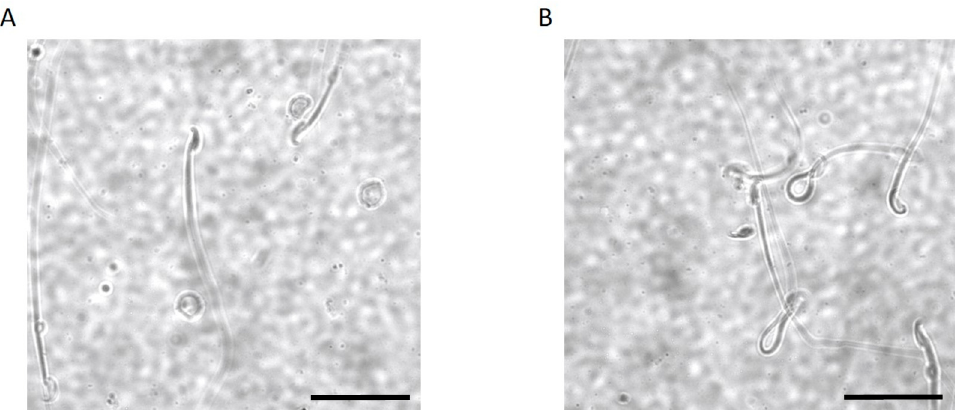
Figure 3. Viability and progressive motility of spermatozoa was comparable in WT and KO mice. The box plots report the evaluation of viability ( A ) and progressive motility ( B ) for spermatozoa collected from WT and KO mice. Both viability and progressive motility were not significantly changed ( p > 0.05) by KO of Kir5.1 channels.